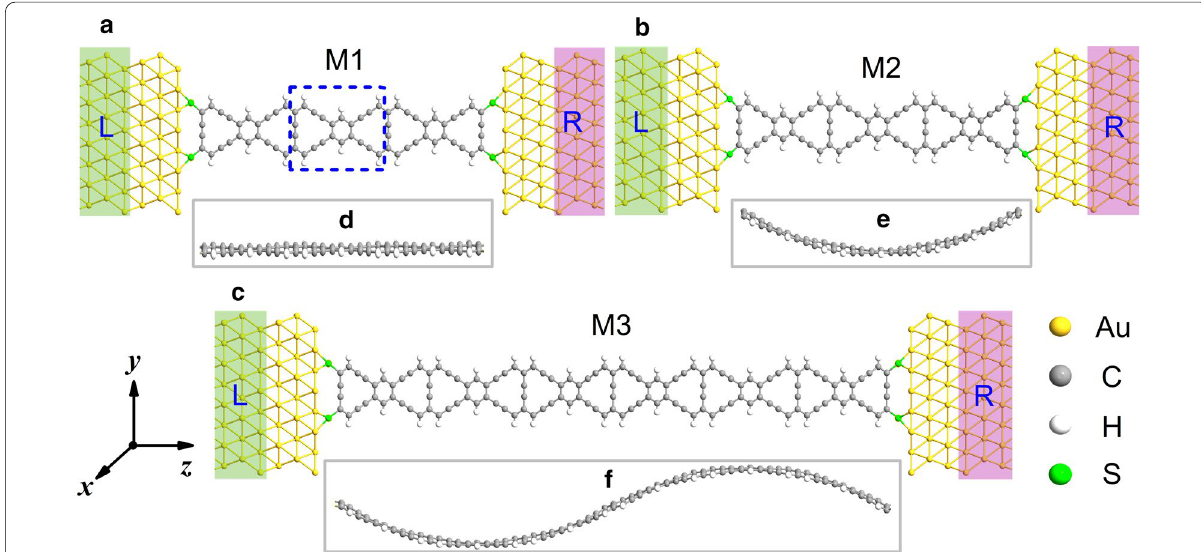
Fig. 1 (Color online) Schematics of the molecular junction models has been displayed as a M1, b M2 and c M3, whose scattering region is flat, curved (U-shape) and double-curved (S-shape), respectively. The blue dashed rectangle in panel a donates the repeated unit cell of ZγGYNR, whose lattice constant is 12.297 Å . For clarity, the side-view in the scattering region for d M1, e M2 and f M3 corresponding to a – c have also been exhibited. L/R represents the left/right electrode